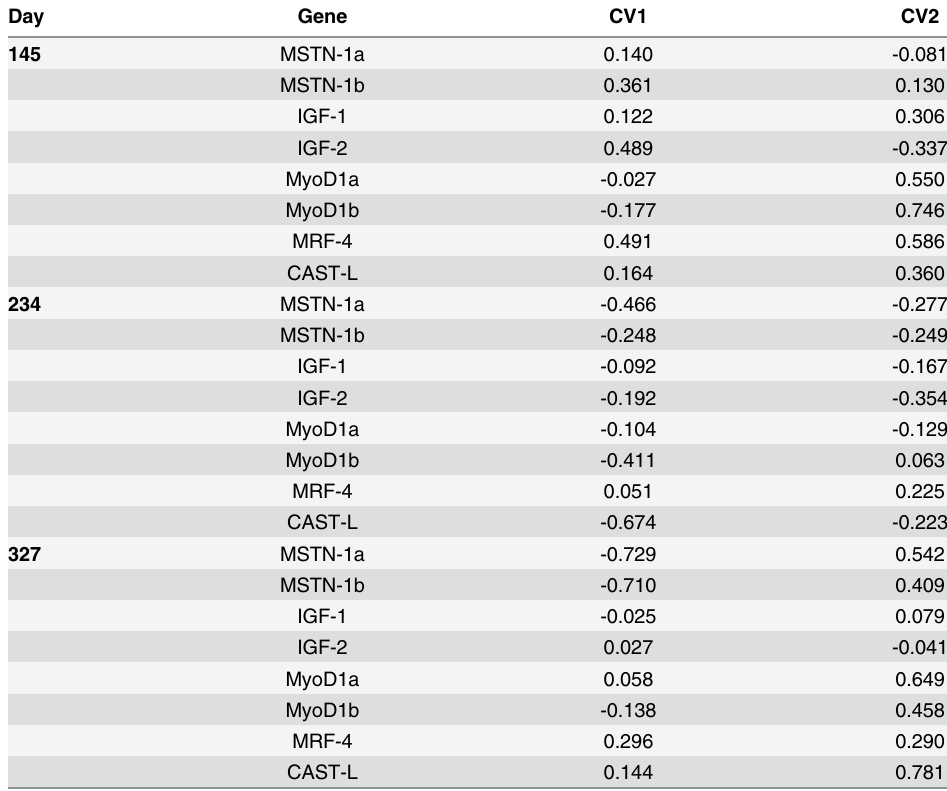
Table 1. Correlation between transcript abundance and the first (CV1) and second canonical variates (CV2) at 145, 234, and 327 days post-fertilization for eight muscle growth-related